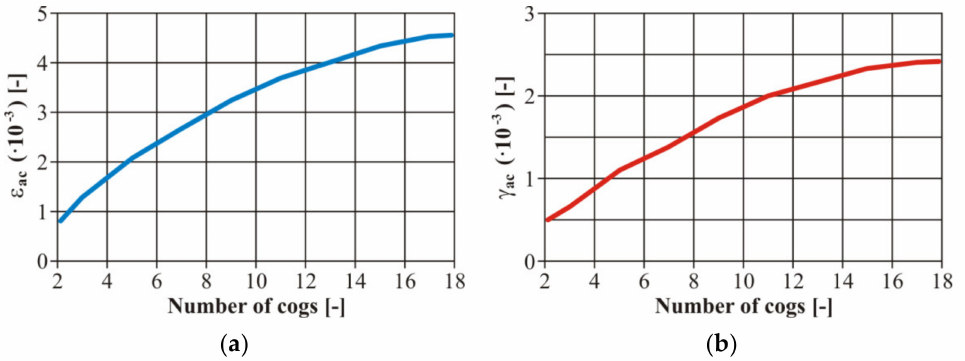
Figure 16. The final calibration curves of the total deformation of the welded material EN AW 6063: ( a ) bending stress; ( b ) torsion